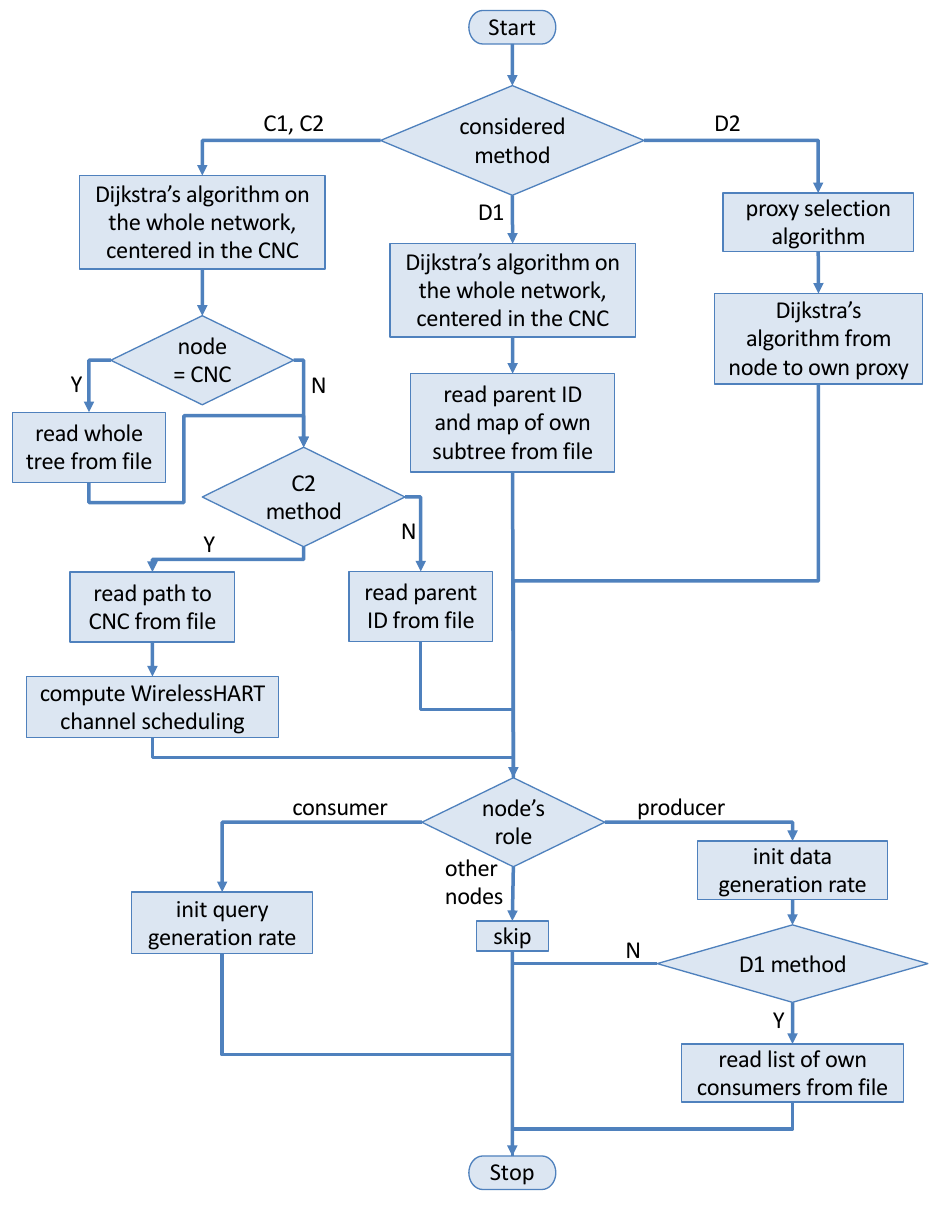
Figure 2. Flowchart representing the adopted methodology. The flowchart must be taken as reference in the following